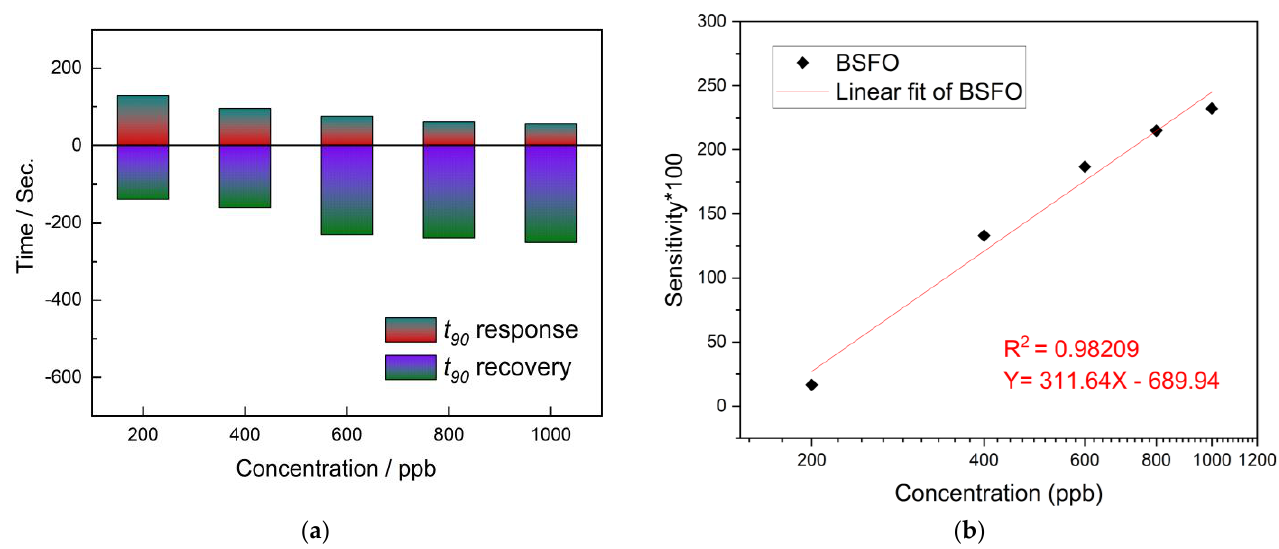
Figure 8. ( a ) Response/recovery dynamics. ( b ) Logarithmic dependency for the BSFO sensor.